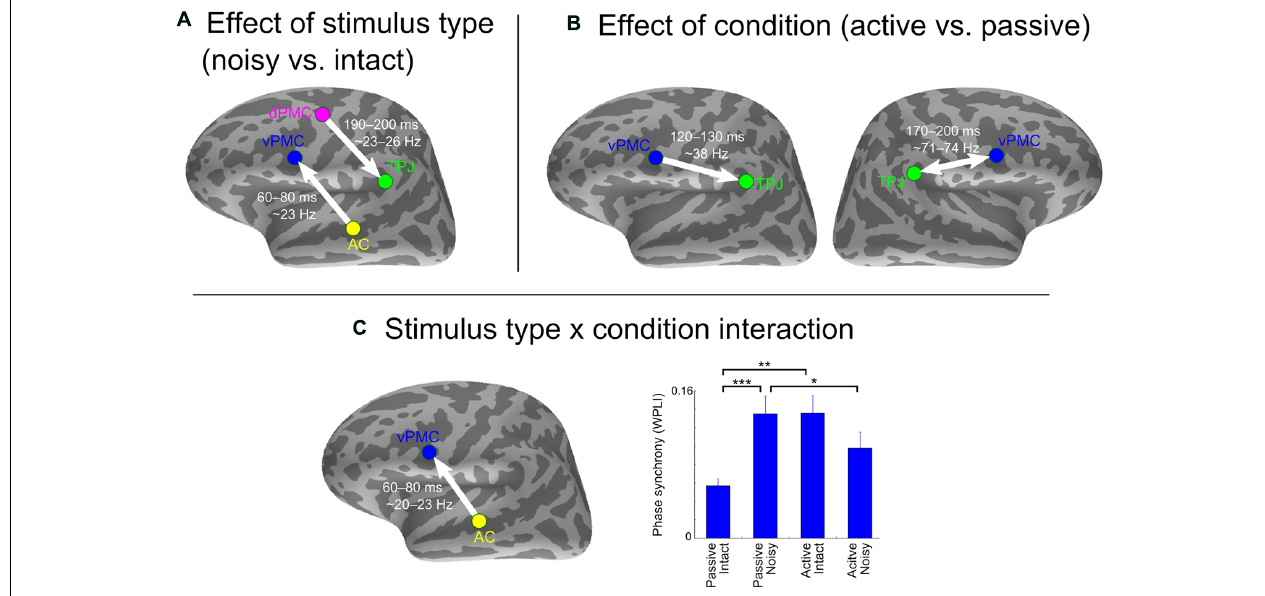
time-frequency point of strongest interaction.The arrows indicate SEM-derived directionality effects based on the pairwise path coefficients. The double arrow denotes undirected interaction. Asterisks indicate significant differences (* p < 0.05, ** p < 0.01, *** p < 0.001, uncorrected). Error bars indicate